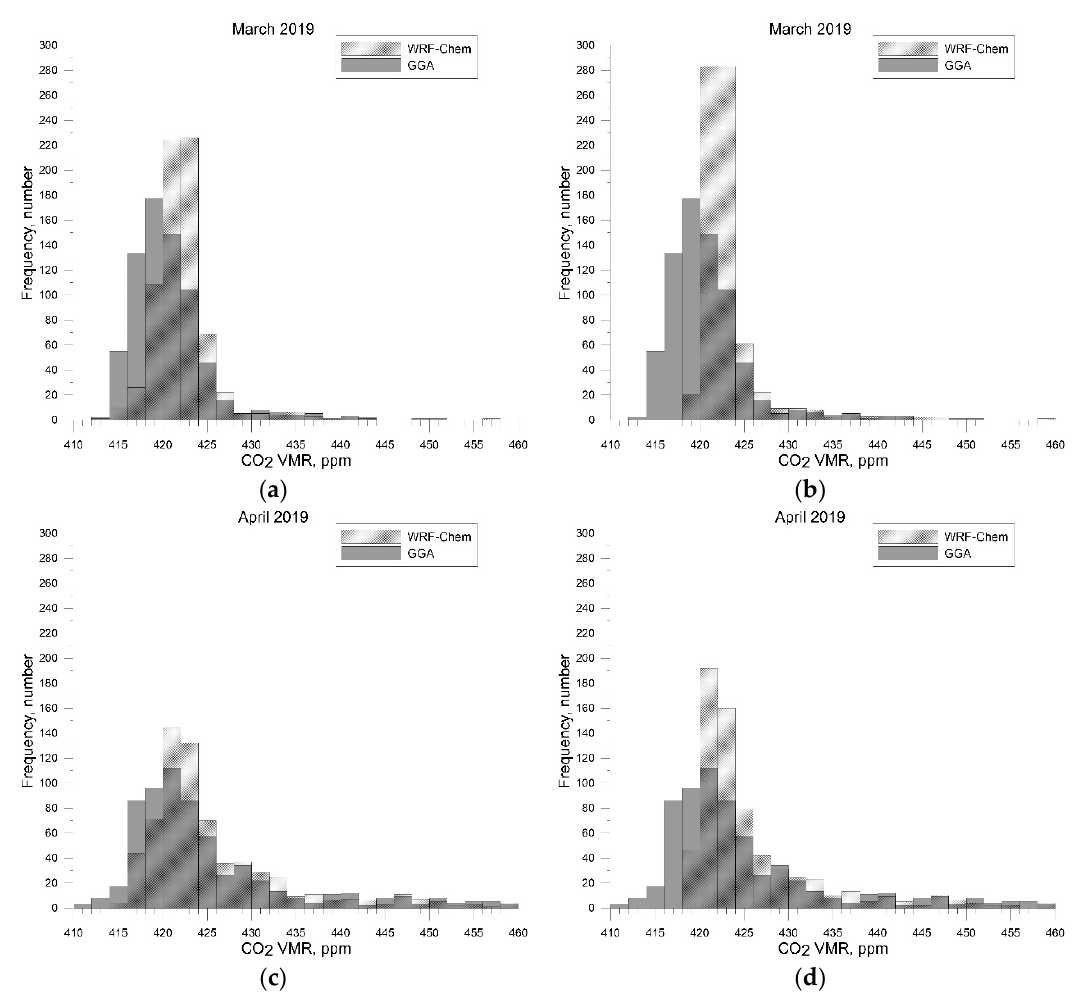
Figure 8. Histograms of the ground-level CO 2 mixing ratio according to the in situ observations and WRF-Chem data (runs with time-varying biogenic and anthropogenic fluxes ( a , c ) and with only time-varying anthropogenic emissions ( b , d )) in Peterhof in March and April 2019.